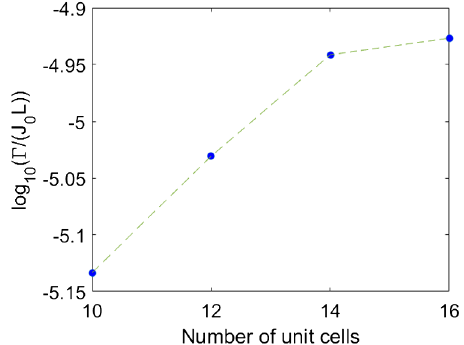
FIG. 9. Size dependence of the interband scattering rate normalized by the size of the system, Γ = ð J 0 L Þ . As the number of unit cells, L , is changed, the density of particles is held fixed at ρ ¼ 0 . 5 . The parameters used for this figure were ω ¼ 0 . 3 , λ ¼ 0 . 56 , U ¼ 2